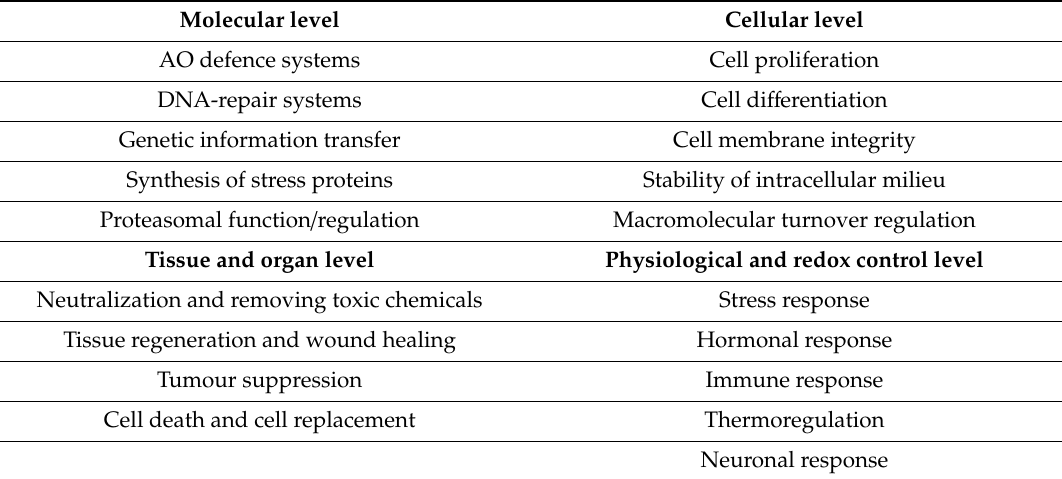
Table 2. Major components of the vitagene network (adapted from References